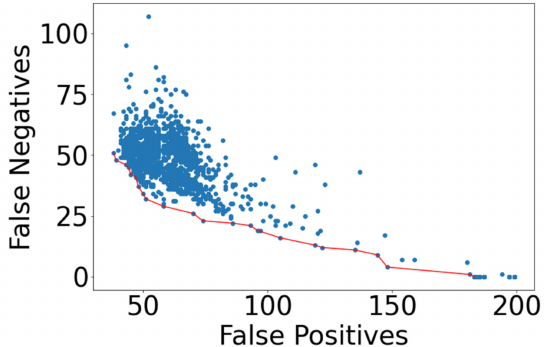
Figure 4. NN modeling results emphasizing lowest FN prediction results, shown by red